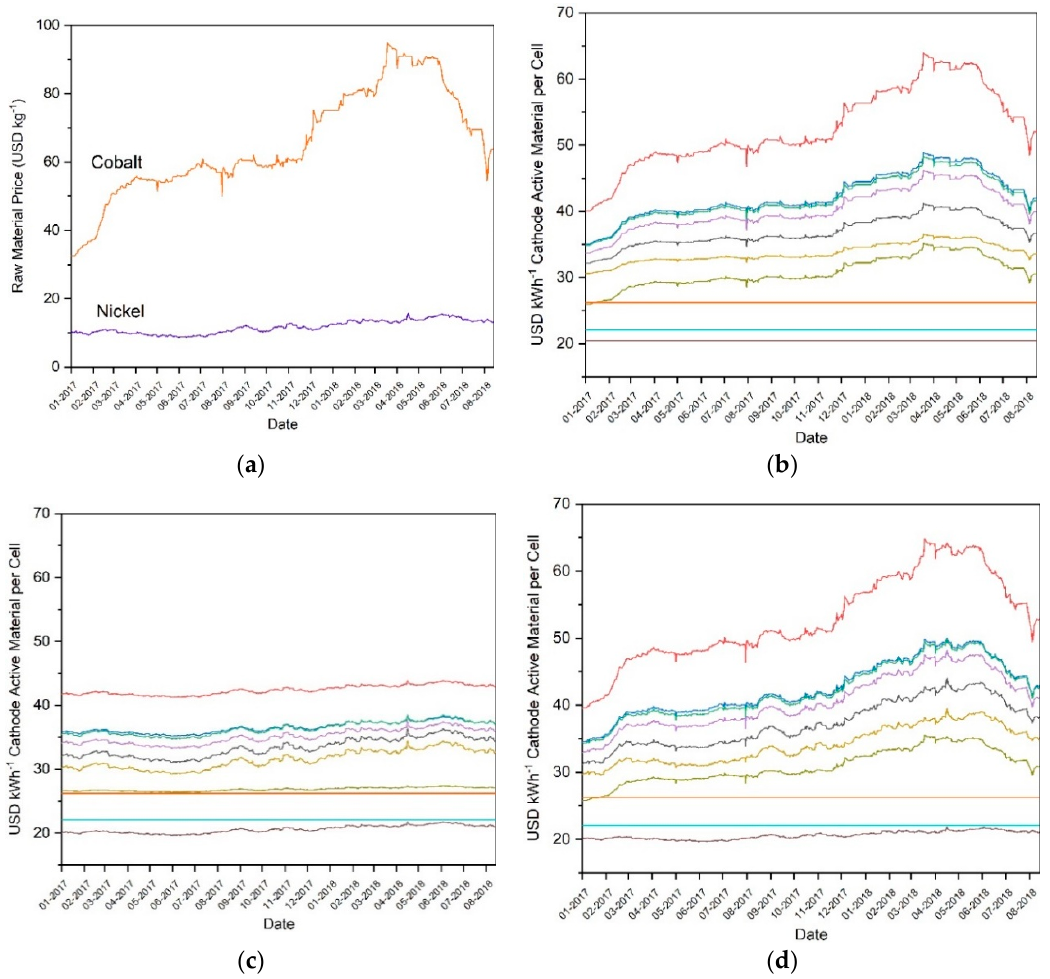
Figure 6. ( a ) Real-world market prices of raw cobalt and nickel metal from 01-2017 to 03-2018, along with sensitivity of total CAM manufacturing costs to real-world market price of ( b ) cobalt, ( c ) nickel, and ( d ) cobalt and nickel during this same time window as determined by CellEst for NMC-111 (red), NMC-442 (blue), NMC-532 (green), NMC-622 (purple), NMC-811 (yellow), NCA (black), LMO (turquoise), LNMO (brown), LR-NMC (olive), and LFP (orange). Data from London Metal Exchange.